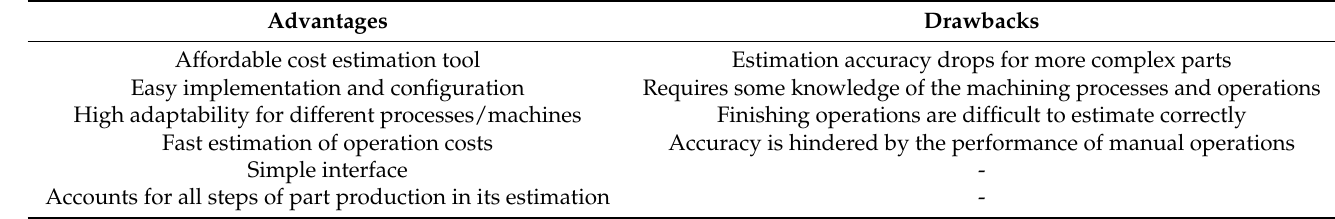
Table 10. Main advantages and drawbacks of the developed cost estimation